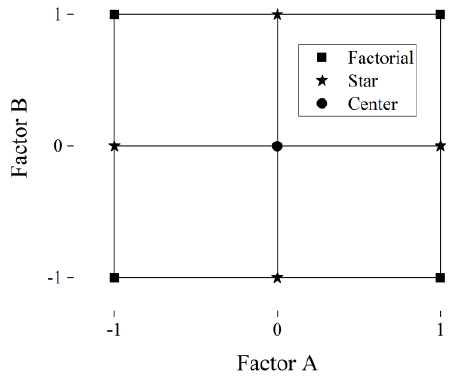
Figure 10. CCF design points.